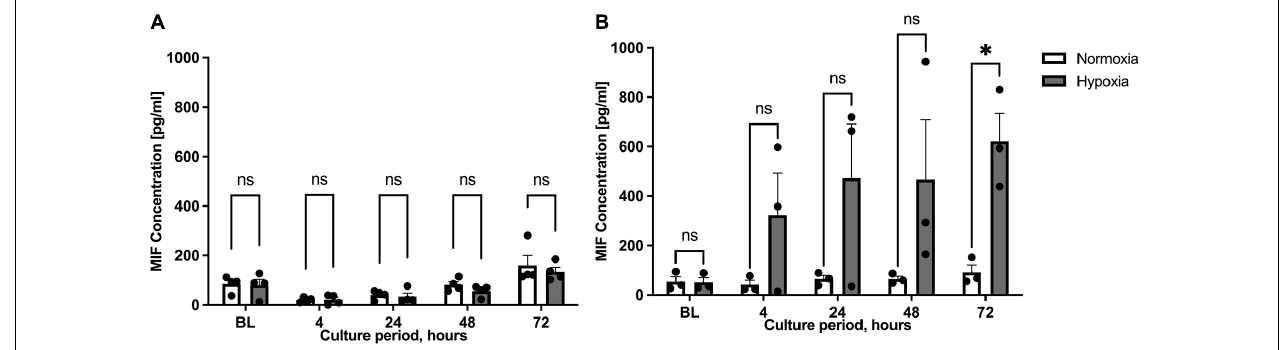
FIGURE 3 | Migration inhibitory factor (MIF) secretion levels under normoxic and hypoxic conditions in patient groups A and B. Cells were cultured in starvation medium at normoxic oxygen levels of 21% O 2 or hypoxic oxygen levels of 1% < O 2 . Separate replicates were cultured for indicated culture periods for independent measurements. Supernatants of ASCs were collected at indicated measuring points and ELISA was performed to determine MIF secretion by ASCs under normoxic and hypoxic conditions. Baseline levels (BL) were obtained at the starting point 0 h. Fat donors were arranged in two groups and analyses were performed for four or three biological replicates, respectively. Group A included healthy adipose tissue samples and group B adipose tissue samples from chronic non-healing wounds. Results are displayed for (A) patient group A ( n = 4) and (B) patient group B ( n = 3). Data are mean values ± SEM (two-way ANOVA, Holm-Šídák’s multiple comparisons test, ∗ p <